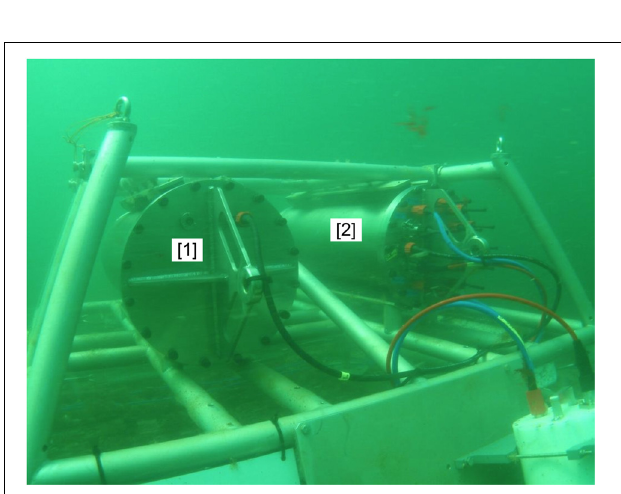
FIGURE 5 | Fully operational node system off Helgoland. The left tube (1) houses a battery pack that provides power for 2–6 h, depending on the power consumption of the sensors. The right tube (2) is the node system which is connected to the breakout box by the red 1000 V power line and the blue Ethernet line. On the front panel, ten sensor ports are available, each providing up to 200 W and an Ethernet connection. All cables between the different node components are wet-mateable by divers, except for the sea cable that enters the breakout box from below via a permanent cable feedthrough (see Figure 4 ). Photo: P. Fischer.